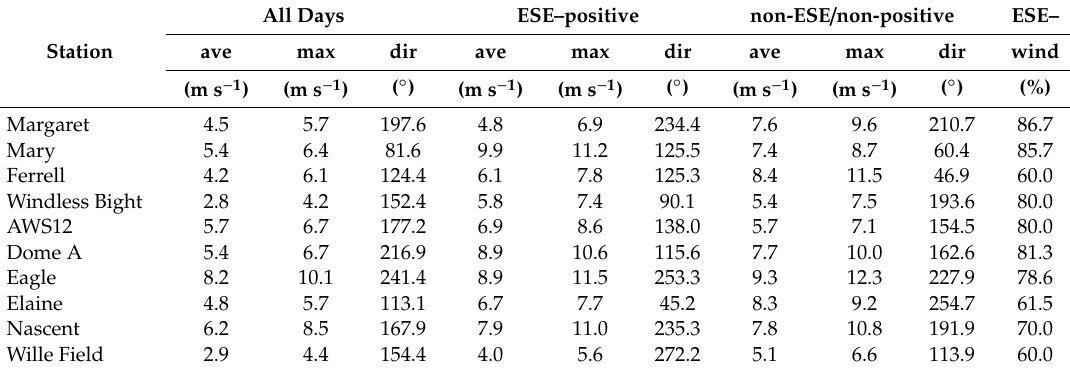
Table 3. Average and maximum wind speed (m s − 1 ) and wind direction ( ◦ ). The column “All days” shows the three factors for all days at each station. The column “ESE–positive” shows the three factors for the days that have both extreme snowfall events (ESEs) and positive snow accumulation; “non-ESE / non-positive” means the days have neither ESE nor positive accumulation. The column “ESE–wind” shows the percentage of ESEs (%) that were accompanied by stronger winds than usual. All Days Station